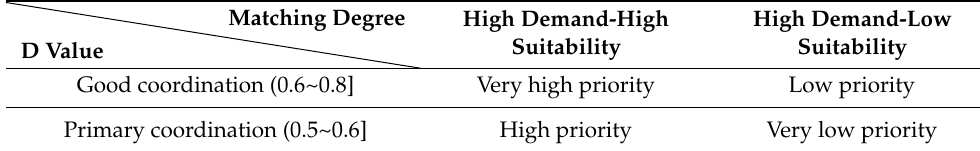
Table 4. Prioritization criteria for brownfields catering for